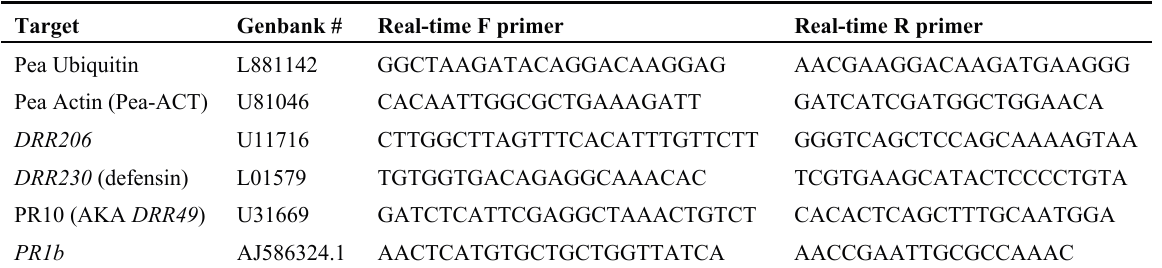
Table 2. Primers selected for real-time PCR analysis of pea PR